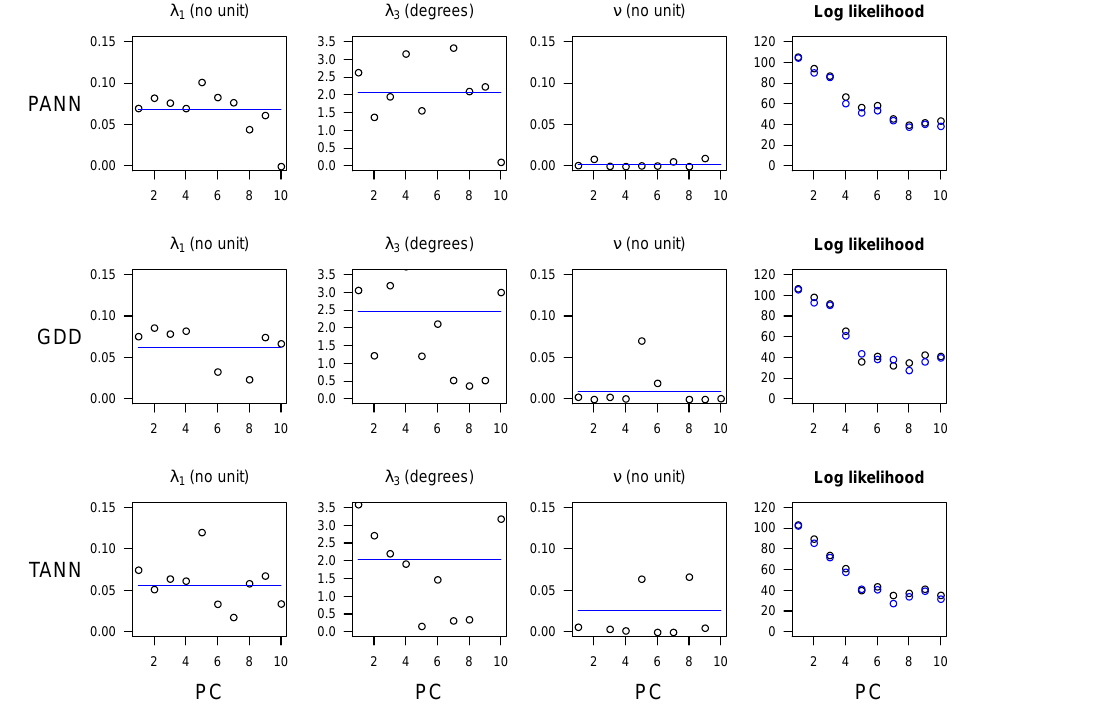
Figure 4. Gaussian process parameters maximising the penalised log likelihood for three variables: GDD, log(annual precipitation), and annual temperature, either (black) optimised for each PC independently or (blue) optimised based on the product of the likelihoods of the first 10PCs, assuming that the same correlation parameters are used on all PCs. The maximised log likelihood associated with each PC is given for